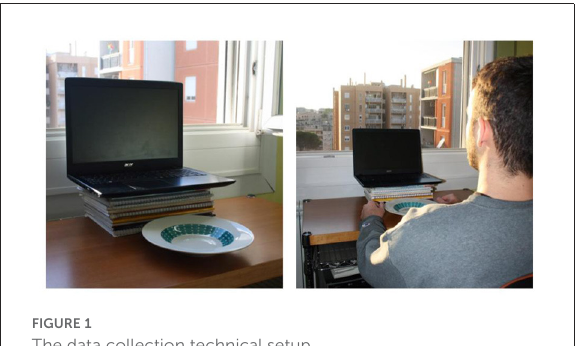
FIGURE1 The data collection technical